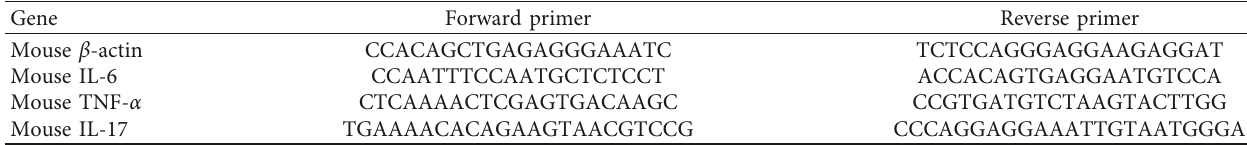
Table 1: qPCR primers sequences.